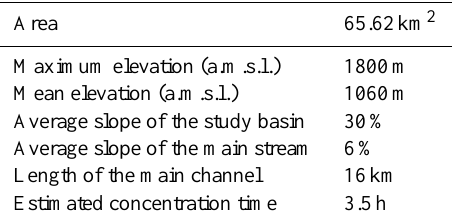
Table 2. Physiographic properties of the study basin. The con- centration time t c has been calculated using the method of Watt and Chow (1985); see also Loukas and Quick (1996) and Dingman (2002).